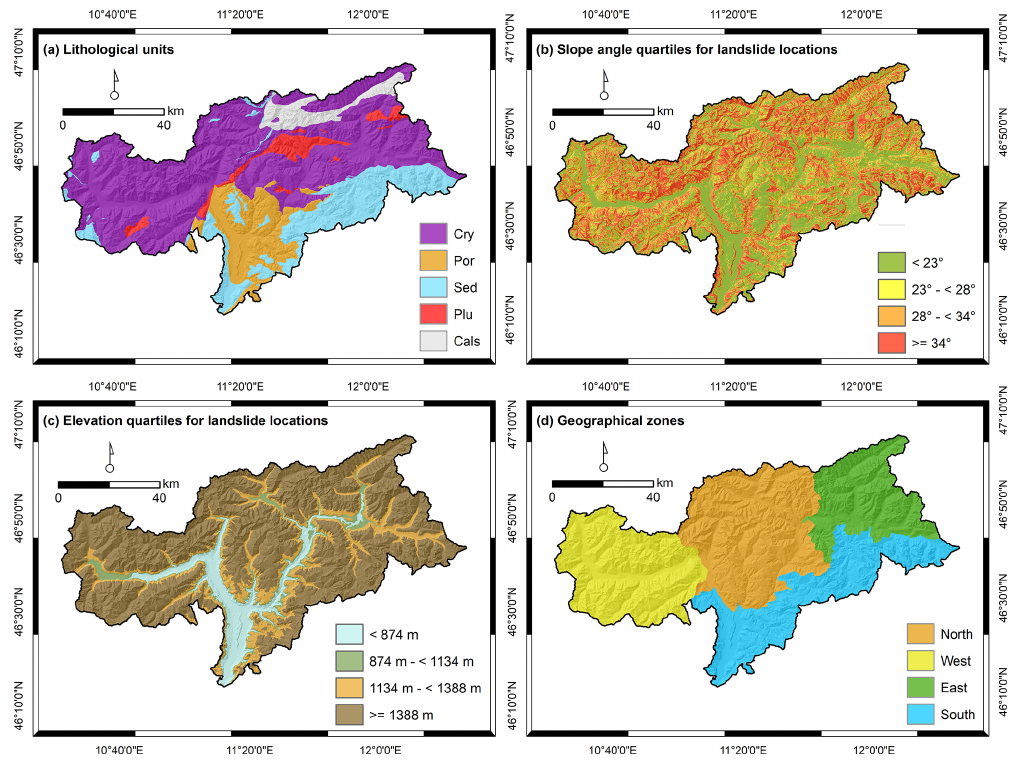
Figure 2. Spatial environmental maps used for leave-one-factor-out cross-validation. The lithological map (a) shows the classes crystalline basement (Cry), porphyry (Por), sedimentary rocks (Sed), plutonite (Plu), and calcschists with ophiolites (Cals). The quartile classification for slope angle (b) and elevation (c) is based on the final landslide presence sample (i.e. each class contains 25% of landslides). The geographical zonation (d) is based on the intersection of